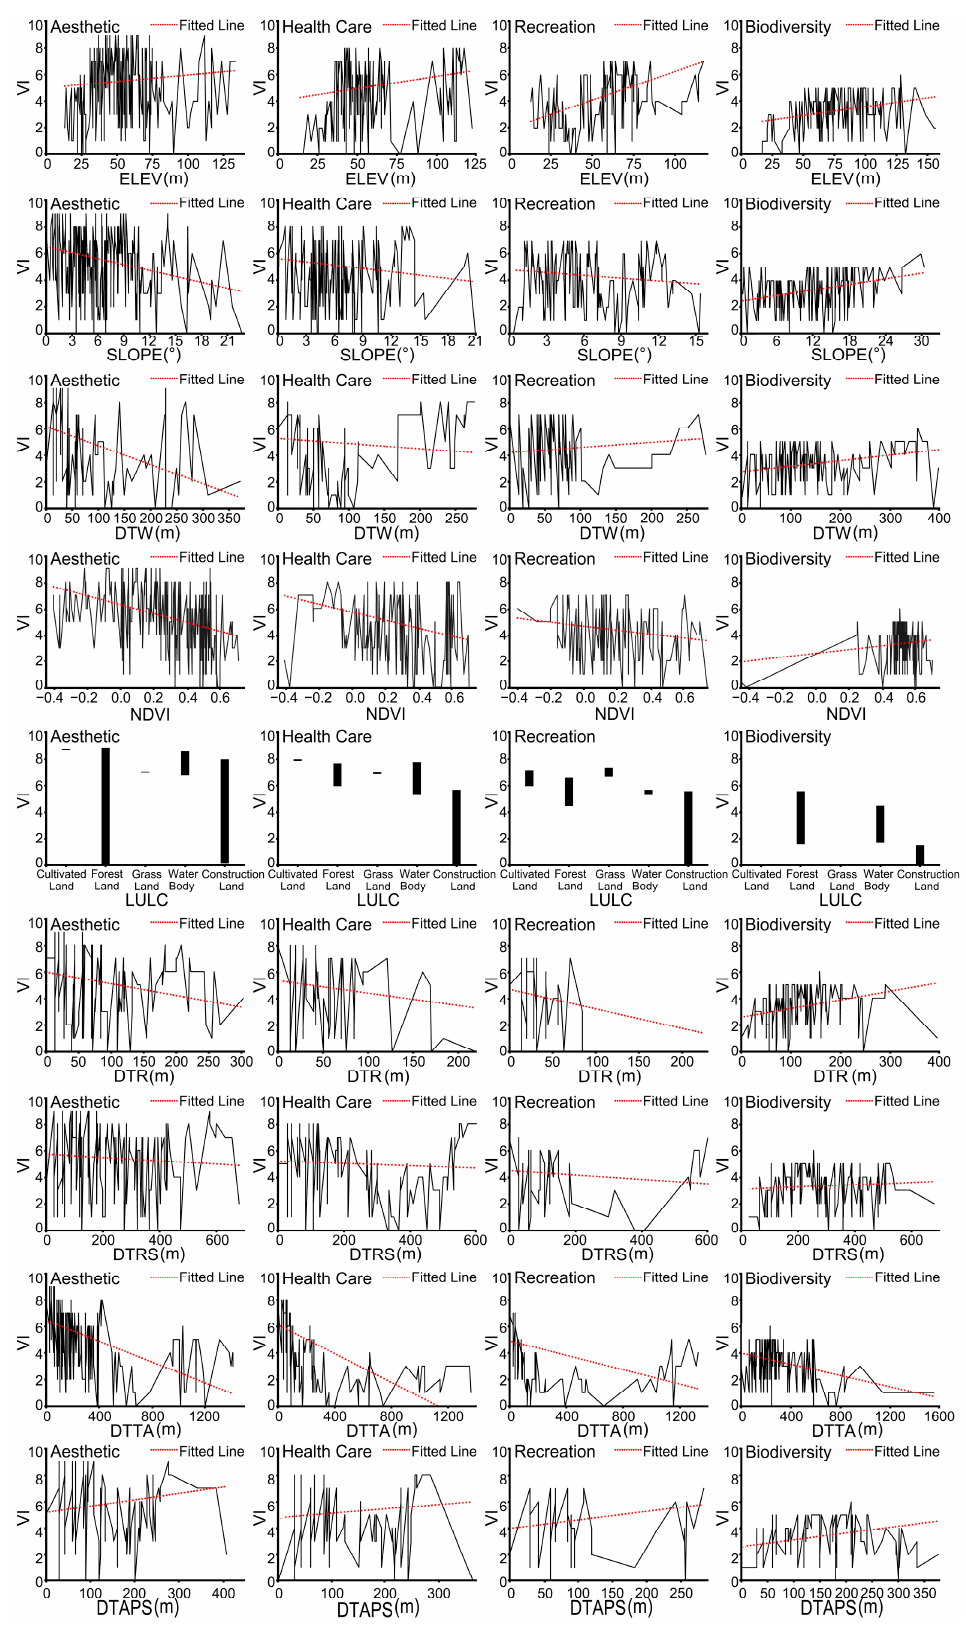
Figure 7. Relationship between the value index of four social value types and environmental variables in the Paifang rural community.